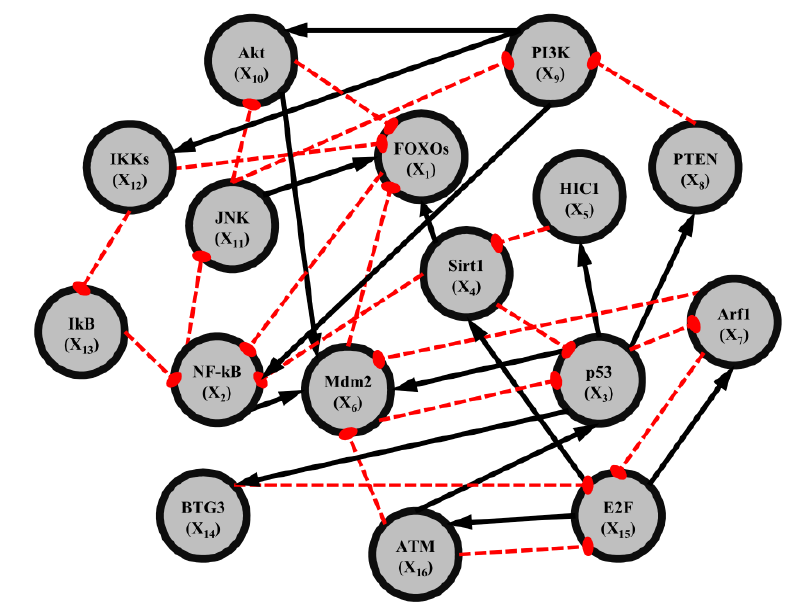
Figure 4. Multiple loops of a gene regulatory network associated with aging-related pathophyiological phenotypes. This aging-related gene regulatory network includes 16 genes: FOXO , NF-kB , P53 , SIRT1 , HIC1 , Mdm2 , Arf1 , PTEN , P13K , Akt , JNK , IKK , IkB , s BTG3 , E3F1 , and ATM . Dashed red lines and black arrows indicate negative and positive parameters of regulated interaction,